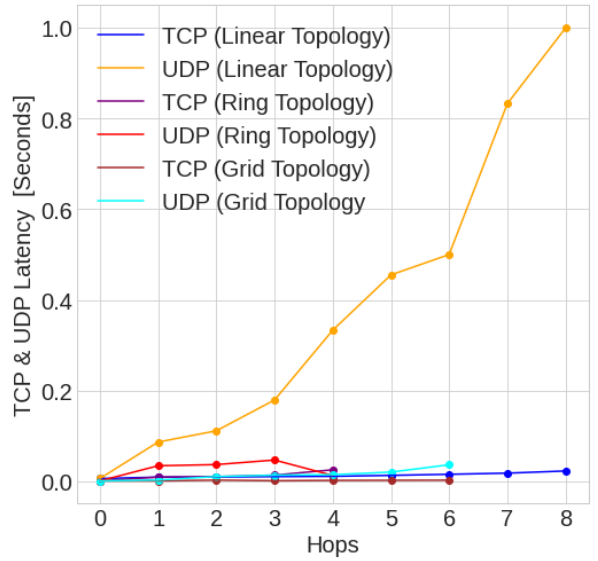
Figure 23. W-iLab1.t TCP and UDP latency.